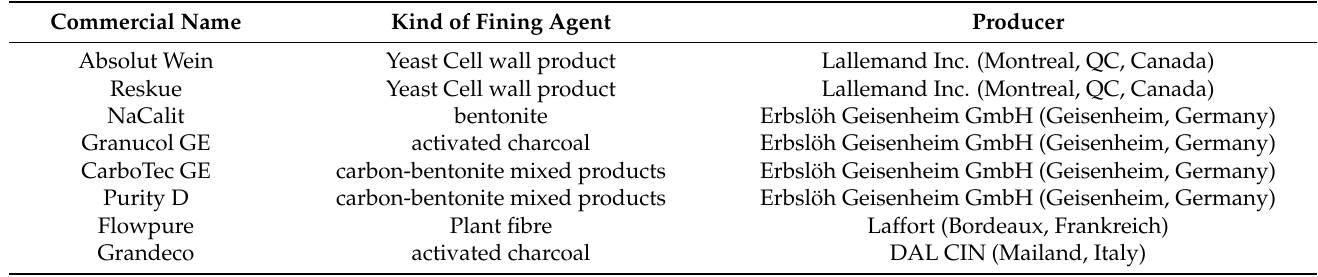
Table 2. Information regarding fining agent applied.